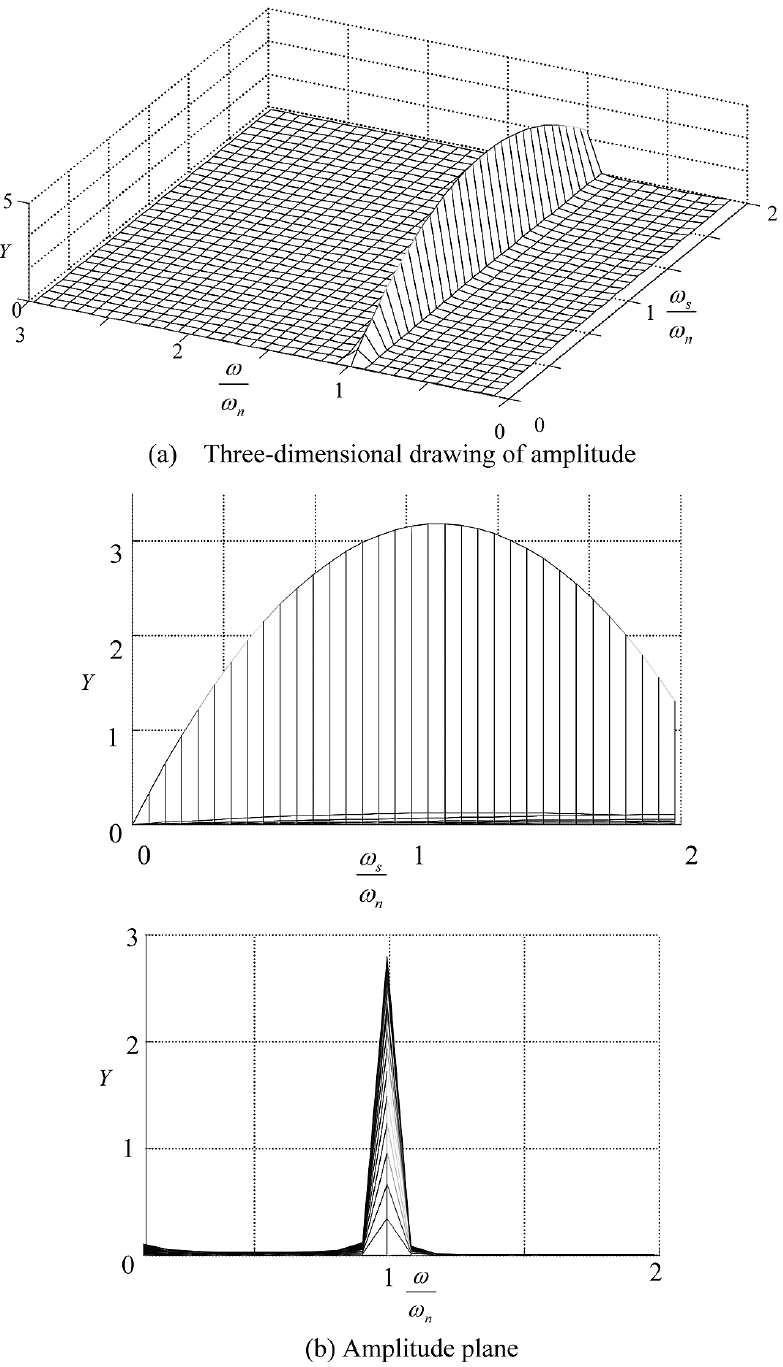
Fig. 3. Jumping phenomenon of the